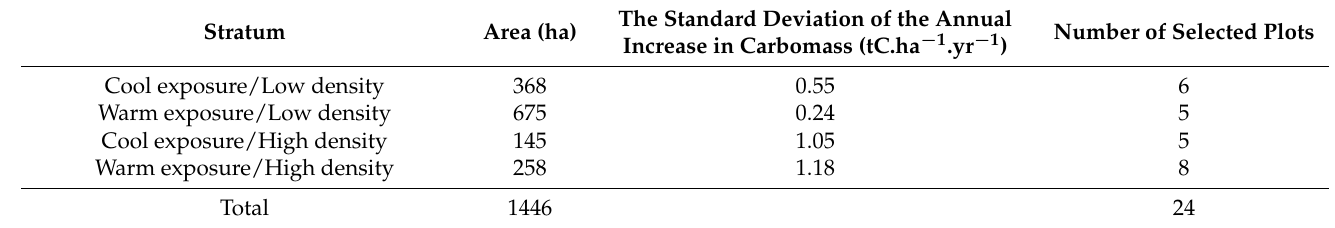
Table 1. Characteristics of the selected sampling strata.